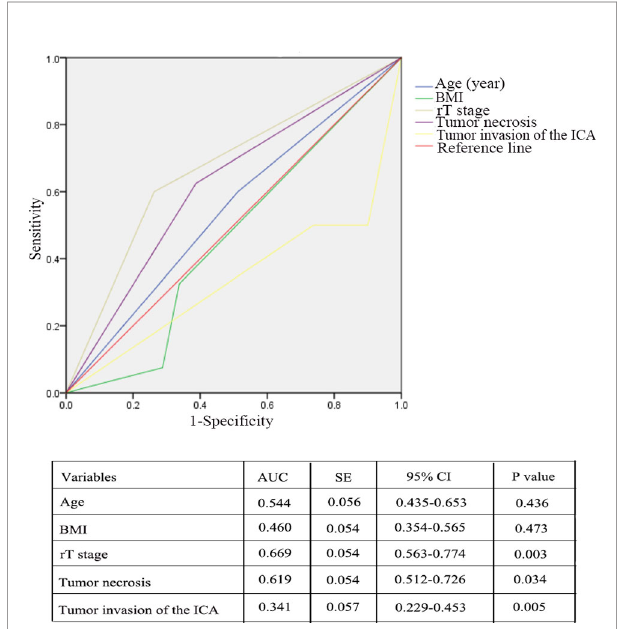
FIGURE 6 | Receiver operating characteristic analysis revealed that the rT stage was the best predictor for overall survival (OS). The area under the ROC curve for rT stage was 0.669 (P =